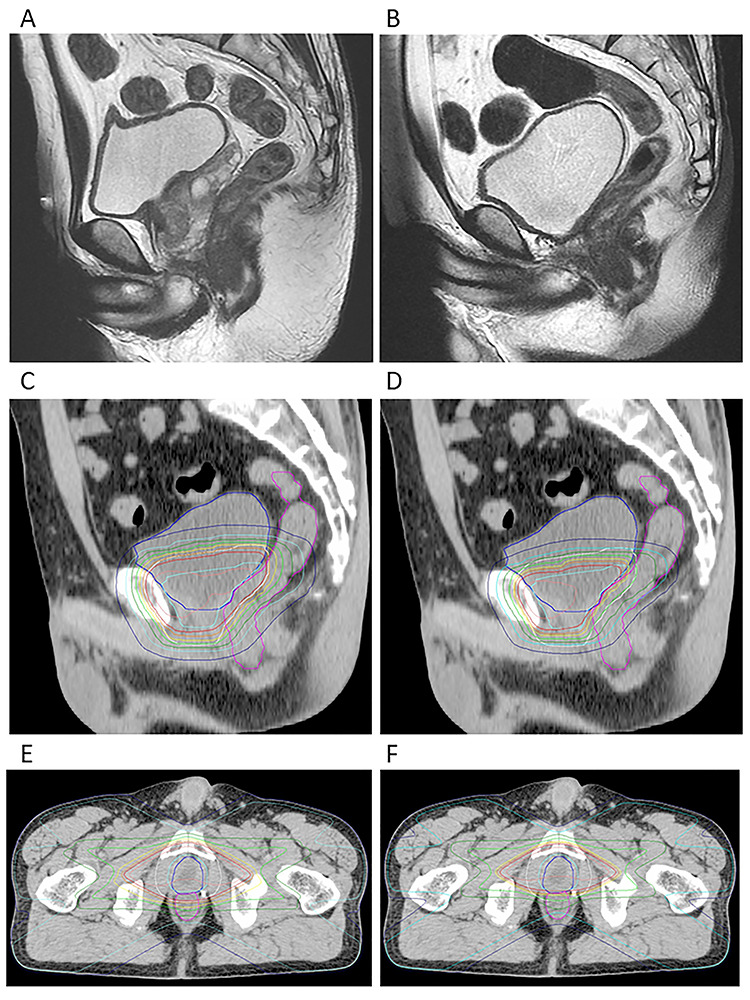
Representative dose distribution of hypofractionated salvage radiotherapy. MRI images before (A) and after (B) radical prostatectomy. Dose distributions: sagittal views of the initial (C) and boost (D) plans and axial views of the initial (E) and boost (F) plans (isodose lines: 95% in red; 90% in orange, 80% in yellow, 70% in yellow–green, 50% in green, 30% in light-blue, and 10% in blue).